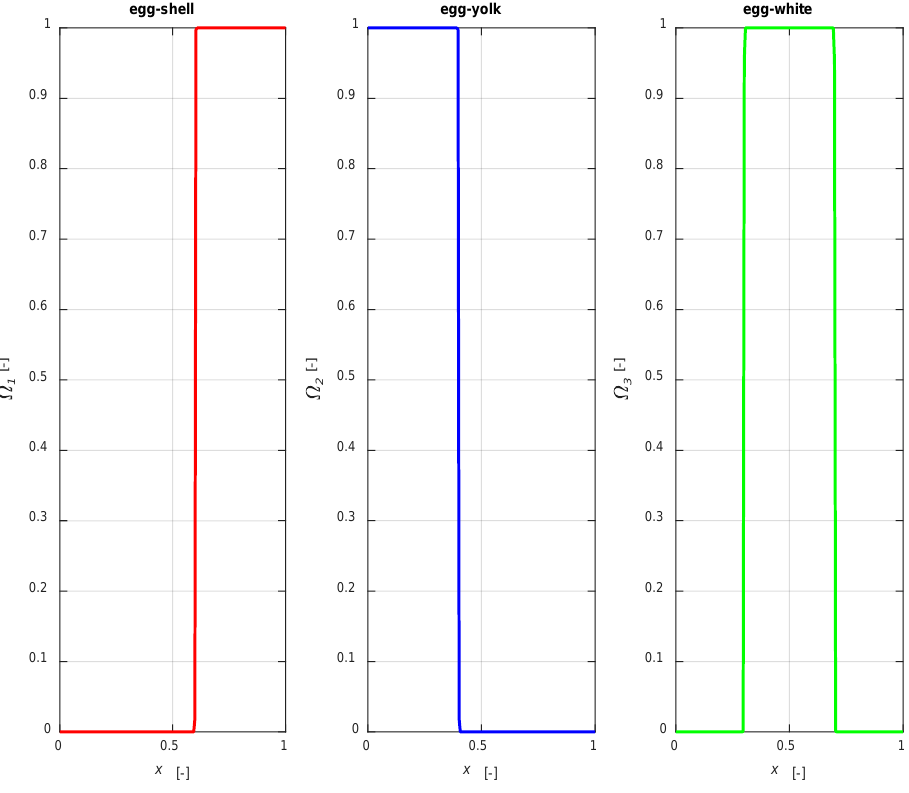
Figure 2. The distribution functions (2)–(4).